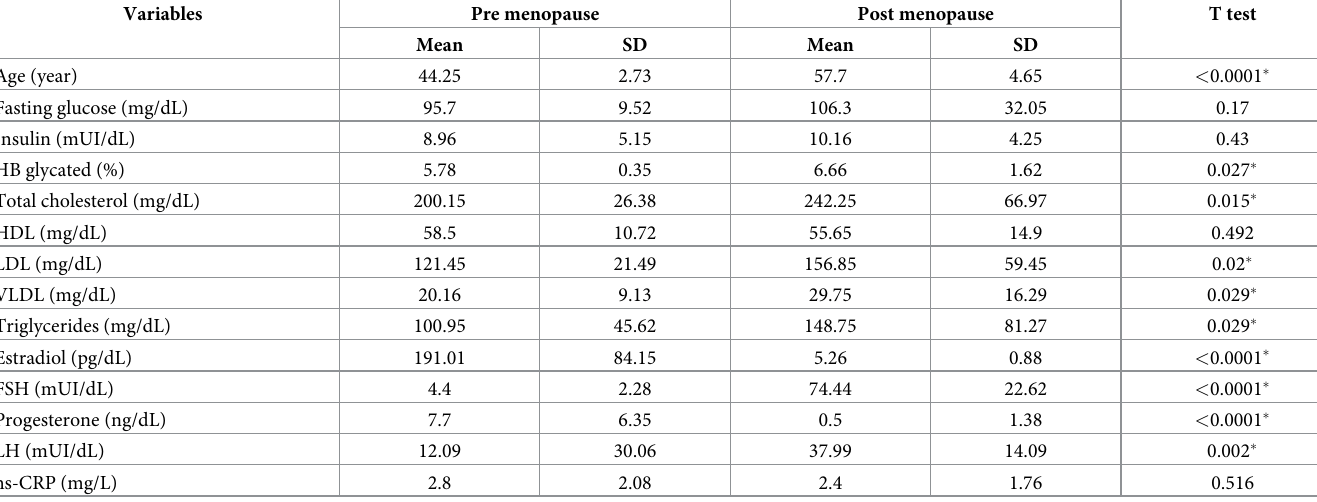
Table 1. Demographic and clinical characteristics of the women in pre-menopause and post-menopause groups. S ã o Luı´s, Maranh ã o, 2013. Variables Pre menopause Post menopause T